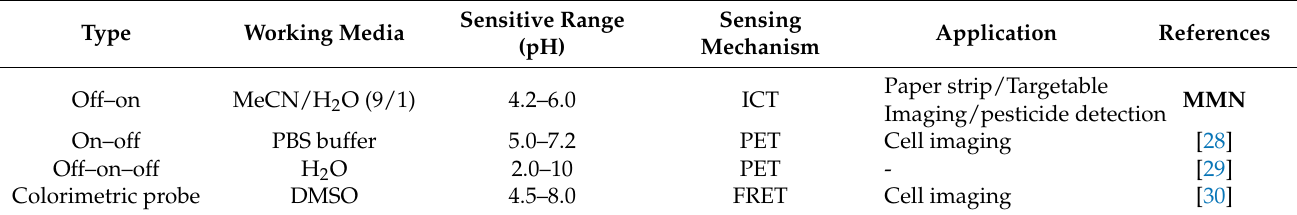
Figure 5. The photographs of MMN on test papers with different apparent pH solutions under a UV lamp (365 nm). Table 1. Comparison with other reported pH probes based on naphthalimide.